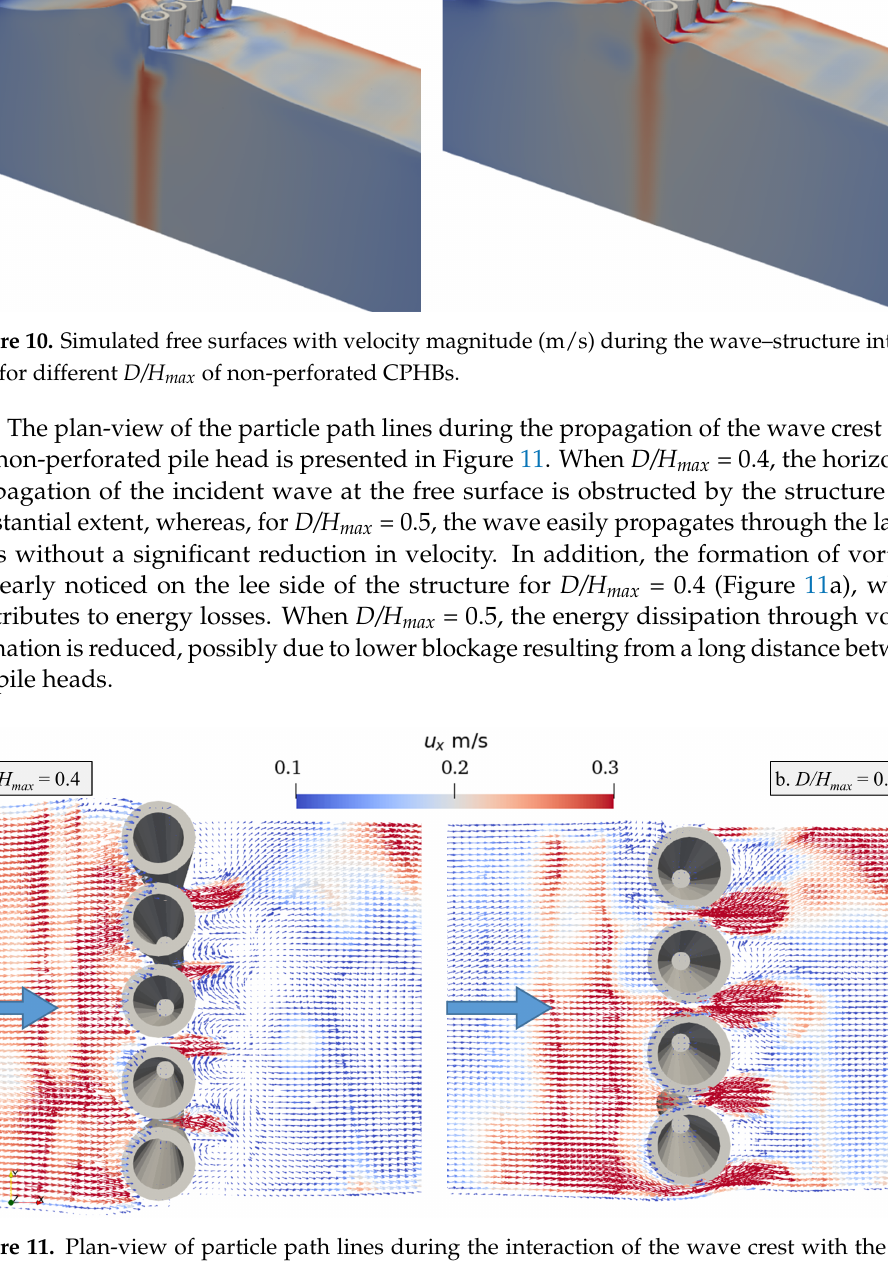
Figure 11. Plan-view of particle path lines during the interaction of the wave crest with the non- perforated CPHBs for different D/H max at t = 9.10